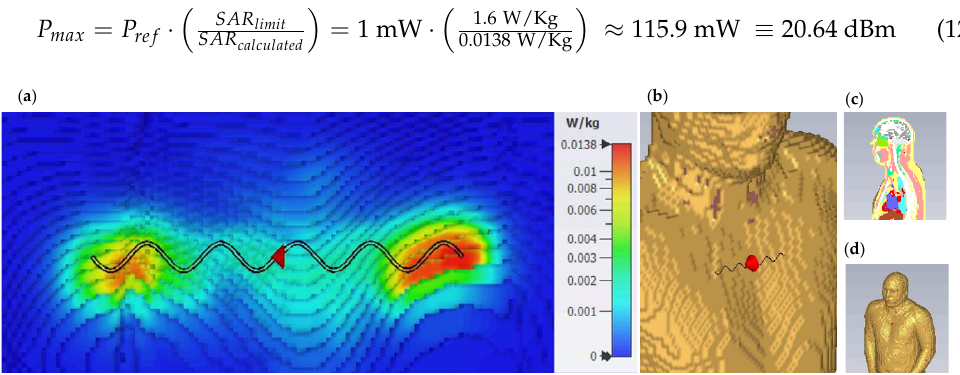
Figure 16. ( a ) SAR for excitation of 1 mW averaged over 1 g of tissue ( b ) Antenna placed on the chest area ( c ) Cross-section of the phantom model ( d ) Perspective view of the phantom model.